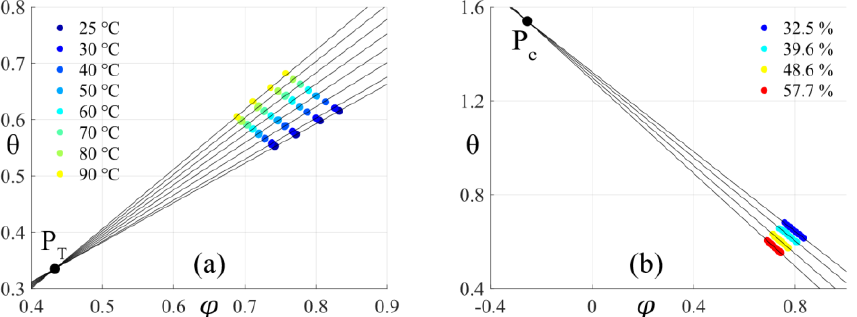
Figure 7. Two-dimensional scatter plot in ϕ - θ space of absorbance data from the calibration set transformed from ν 1 - ν 2 - ν 3 space. Linear fit curves for the same parameter data are shown as black lines and the intersection point of fit curves P as a grey dot. ( a ) Dots are color coded with respect to film temperature. ( b ) Dots are color-coded with respect to urea concentration.